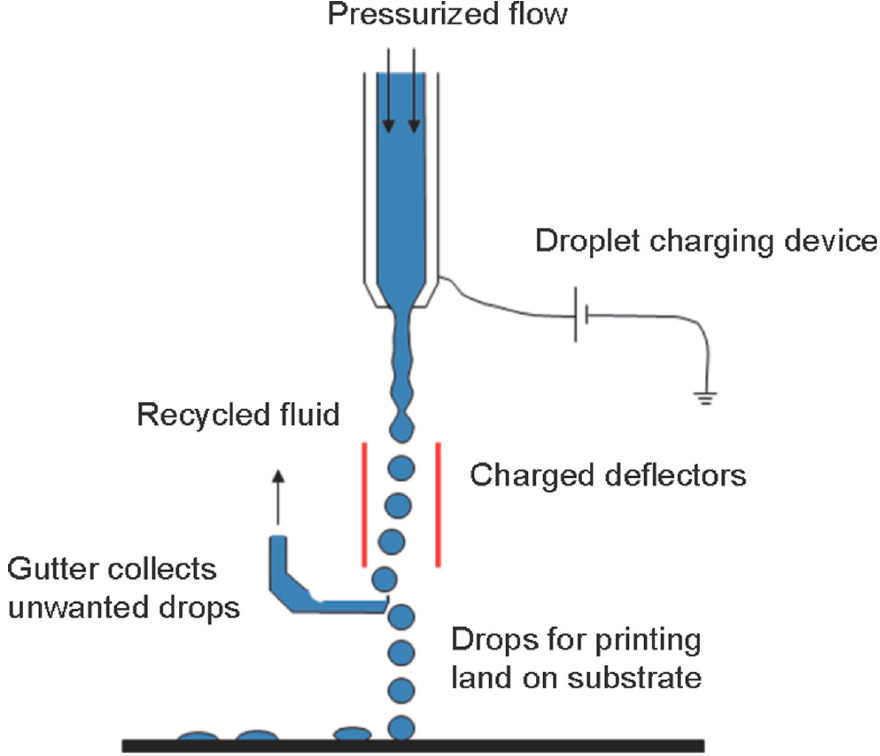
Figure 5. Schematic diagram depicts the basic working principle of ink-jet 3D printing